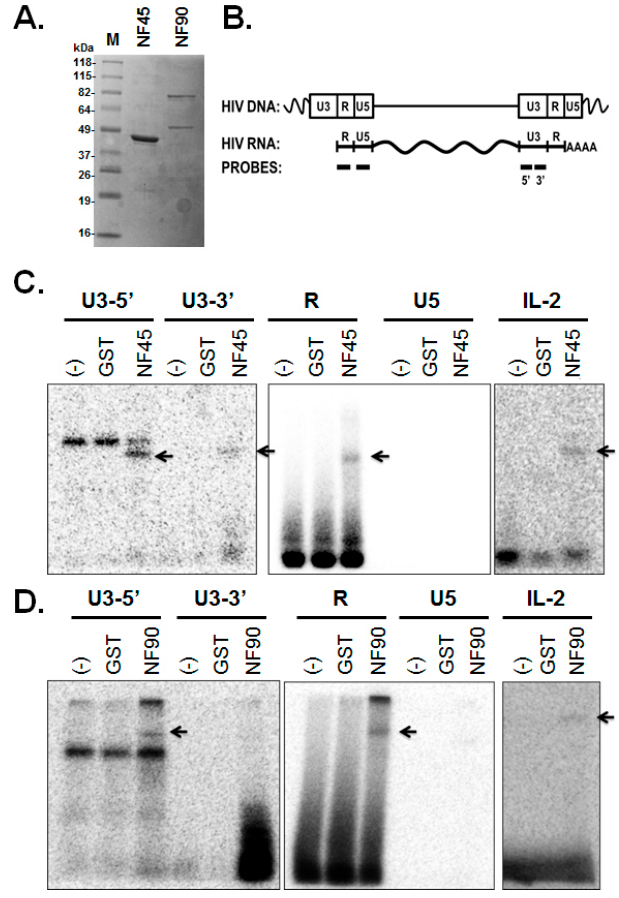
Figure 7. In vitro RNA cross-linking assays. ( A ) Expression of purified rNF45 and rNF90 visualized by SDS-PAGE and staining with Coomassie blue; ( B ) Cartoon depiction of integrated HIV DNA and mRNA. Approximate locations of RNA probes used in cross-linking assays are shown at bottom ( C ) In vitro RNA binding assays with rNF45 ( C ) and rNF90 ( D ). Recombinant proteins were incubated with radiolabeled RNA probes to regions indicated at top (IL2 3 ′ UTR was used as a positive control). Samples were cross-linked by UV exposure and treated with RNase A prior to separation by SDS-PAGE. Gels were imaged using a phosphorimager. Arrows indicate expected migration for HIS-tagged NF45 ( C ) and NF90 ( D ) proteins.